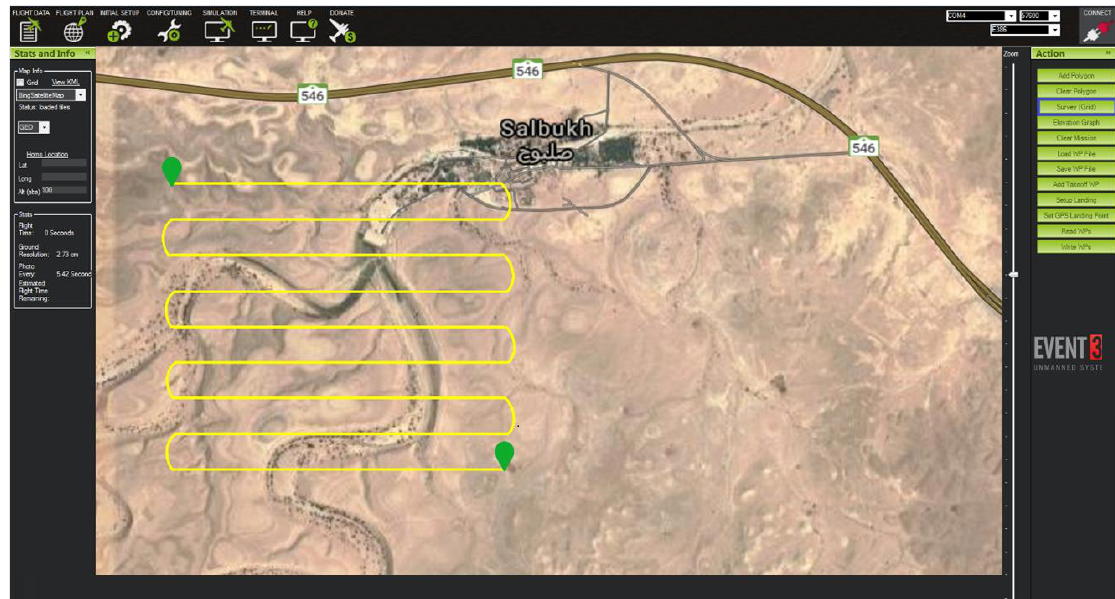
Figure 2. Proposed structure of a drone for use in search-and-rescue operations.